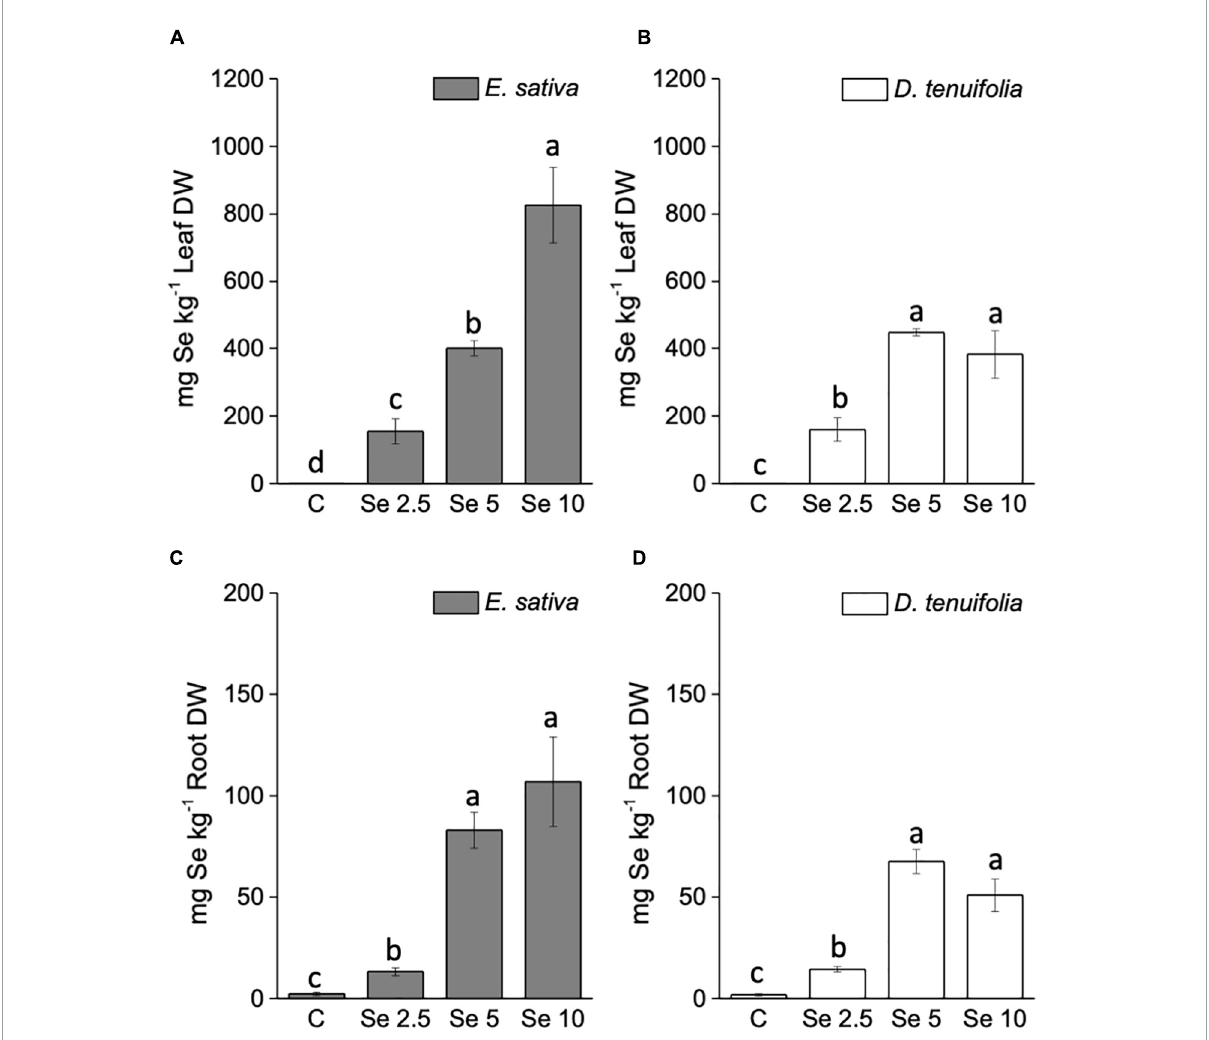
FIGURE2 Selenium concentration in leaves (A,B) and roots (C,D) of E. sativa and D. tenuifolia plants grown in soil and subjected to foliar fertilization with selenate dosages ranging from 0 to 10 mg per plant. Data shown are the mean ± SD of three replicates. Different letters above bars indicate significant differences between the means ( p <